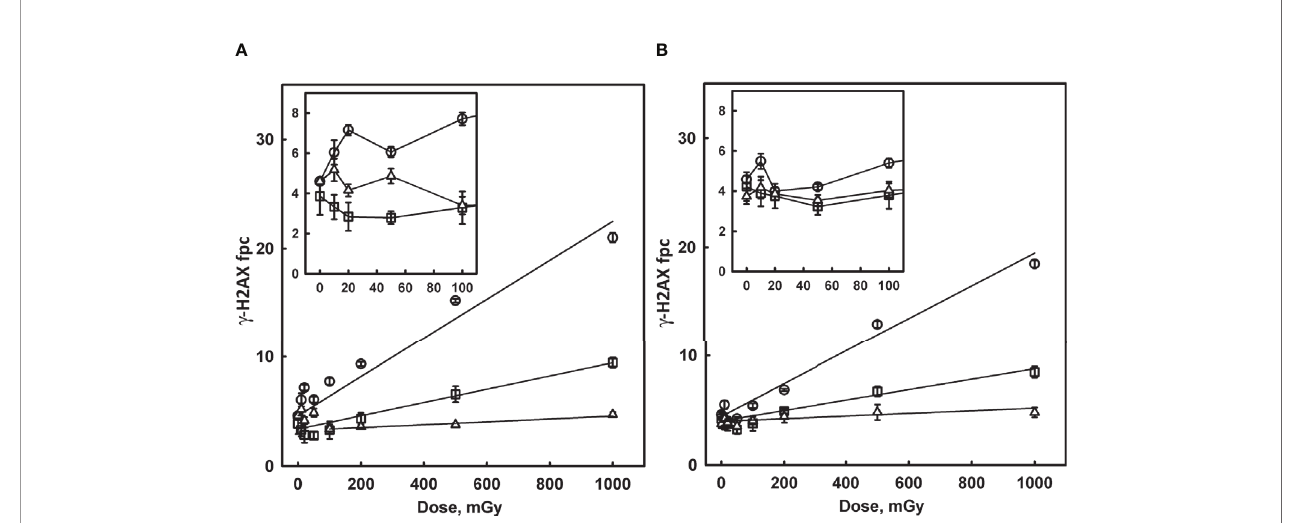
FIGURE 4 | Induction of g -H2AX foci in p53 WT (A) and p53-null HCT-116 cells (B) by low doses of X-rays. Cells were irradiated with various doses of 160 kVp X-rays and fi xed 0.5 hours (circles), 4 hours (squares) and 24 hours (triangles) post-irradiation. Inserts in the top left corner of each panel show detailed pattern of the dose response in the region of small doses from 10 to 100 mGy. Solid lines in the main panels represent results of linear regression (ignoring 10 – 50 mGy data). Values of foci per cell yield per Gy (the slope of linear component) are as follows: 18.8 ± 1.4, 6.05 ± 0.74 and 1.31 ± 0.19 for p53 WT at 0.5, 4 and 24 hours respectively; 15.1 ± 1.3, 4.78 ± 0.65 and 1.20 ± 0.44 for p53-null at 0.5, 4 and 24 hours, respectively.